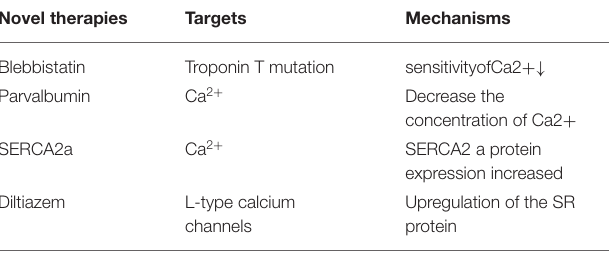
TABLE 2 | Table for the novel therapies. Novel therapies Targets Mechanisms